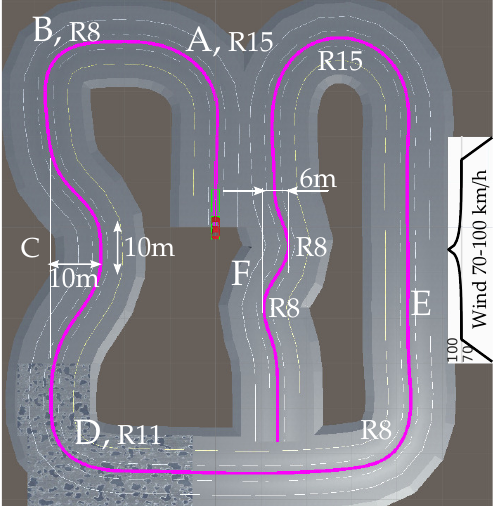
Figure 11. Scenario 1: Track with difficult maneuvers.